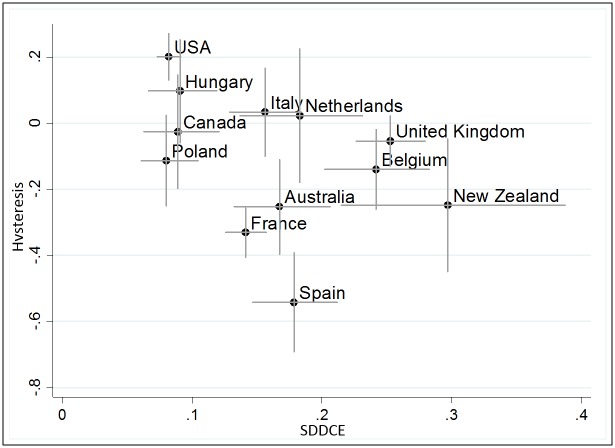
Standard deviation of the detrended cohort effects (SDDCE) and h coefficients in the 12 countries with higher Cohortality Coefficient.